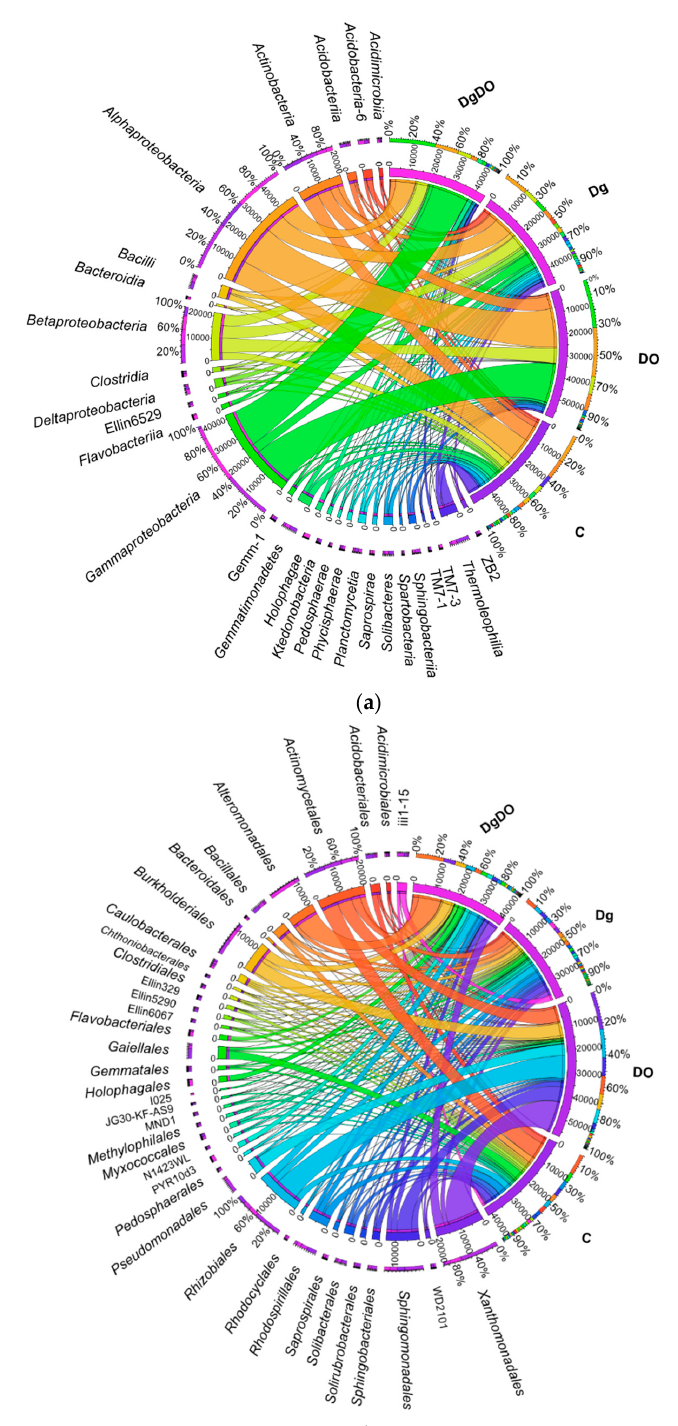
Figure 5. The relative abundance of the dominance class ( a ) and order ( b ) of bacteria in soil with a difference between proportions ≥ 1%. C—non-polluted and non-sown soil, Dg—non-polluted soil sown with Dactylis glomerata , DO—non-sown soil polluted with diesel oil, DgDO—soil polluted with diesel oil and sown with Dactylis glomerata .